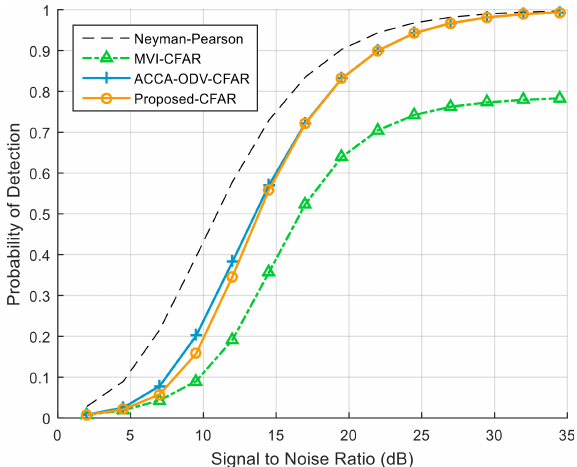
Figure 7. Detection probability on both sides of the reference window, where the numbers of interfering targets on both side of the reference window differ ( N = 36, P fa = 10 − 4 ).